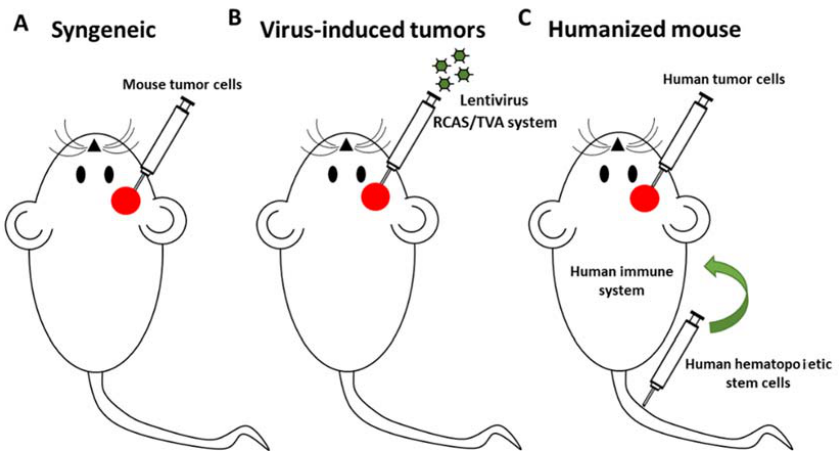
Figure 2. Immunocompetent mouse models for the study of oncolytic virus (OVs) in PBTs. Since the importance of the immune response in the effectiveness of OVs, studies in immunocompetent animal models are needed. Three immunocompetent mouse models are in development to evaluate anticancer therapies, including OVs. ( A ) The generation of mouse tumor cell lines to performed syngeneic immunocompetent mouse models. ( B ) Transduction of specific mouse cell populations with mutated genes to induce tumorigenesis. ( C ) Immunodeficient mice with humanized immune system xenografted with human tumor cells.